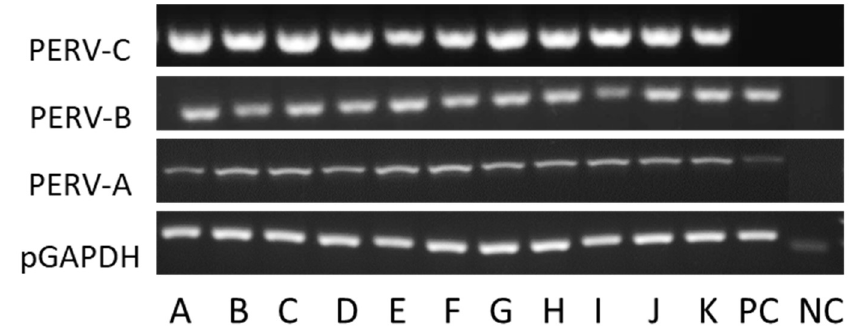
Figure 3. Detection of PERV proviruses in 11 GöMPs using a PCR method. PC, PK15 cells: NC, negative control, water.